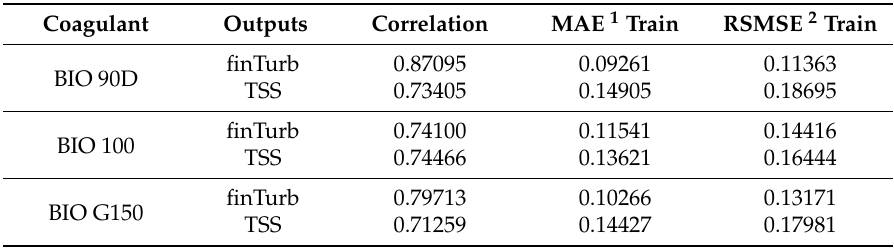
Table 11. Results of the errors in FinTurb and TSS using the quadratic